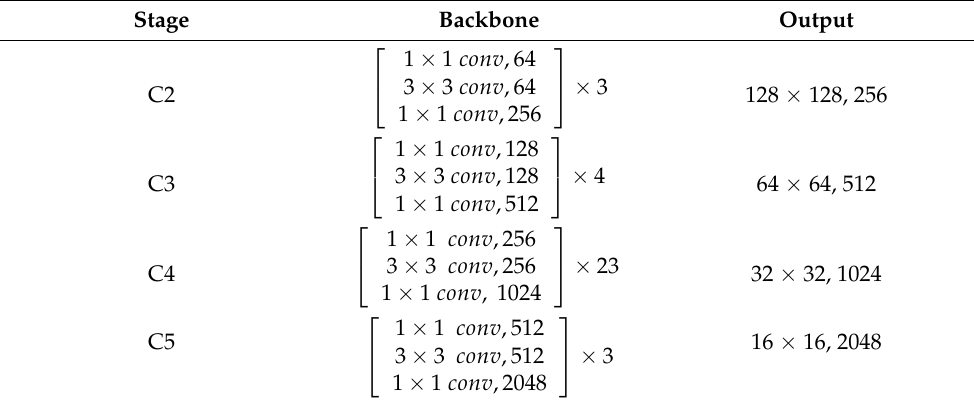
Figure 2. The architecture of the proposed method, which is based on FCOS. The multi-scale enhanced layers are generated by the enhanced feature module and multi-scale feature fusion. For bounding box regression, a context-aware strategy and CIoU loss are introduced to achieve better performance. Table 1. The architecture of the